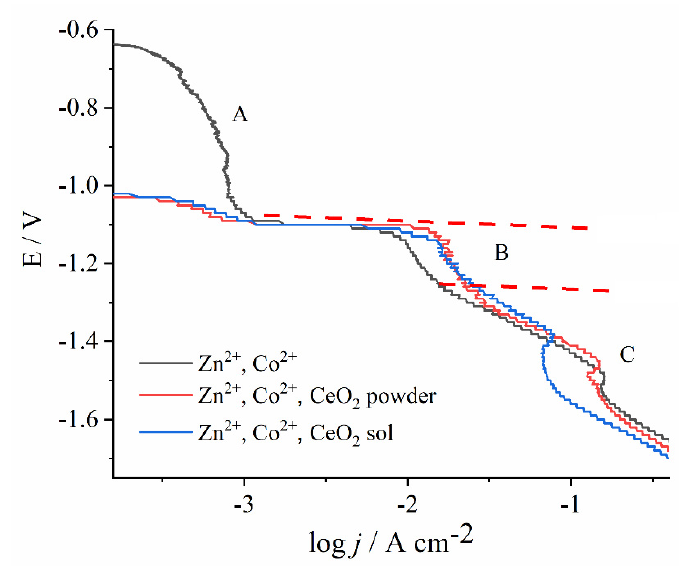
Figure 3. Effect of ceria present in the form of powder or sol in the Zn- and Co-containing bath on the cathodic potentiodynamic curves on steel substrate. The polarization is carried out with magnetic stirring at pH 3.00, with a scan rate of 1 mV s − 1 .